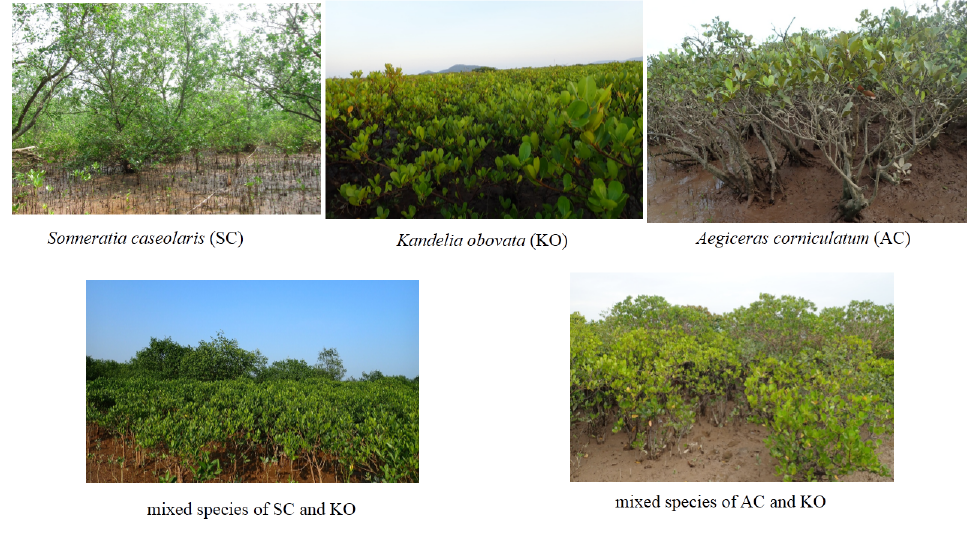
Figure 1. Mangrove communities in North Vietnam (20 ◦ 18 (cid:48) –21 ◦ 22 (cid:48) N, 105 ◦ 10 (cid:48) –106 ◦ 39 (cid:48) E). These photos were taken by T.D. Pham [20].